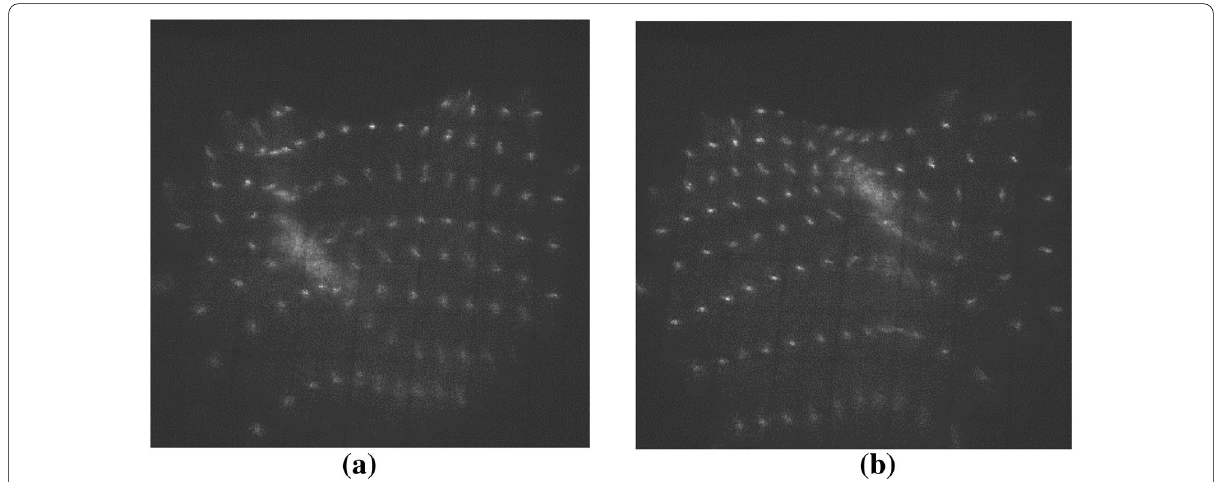
Figure 9 (1, 1) mode experimental